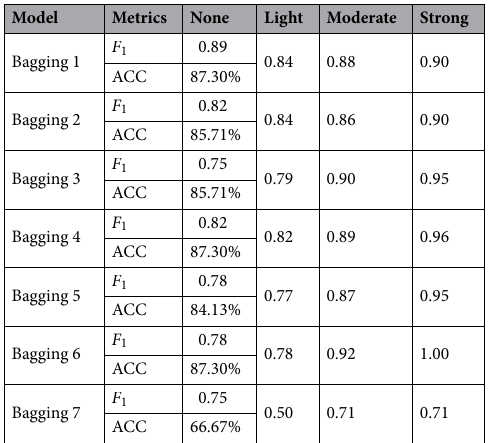
Table 12. The F 1 and accuracy in seven bagging combination models.